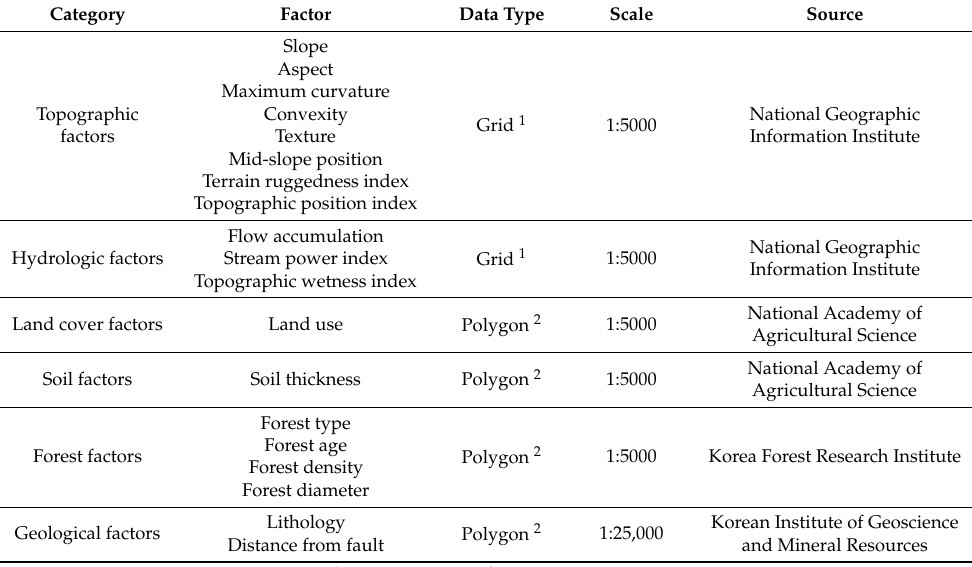
Table 1. Data layers related to landslide susceptibility in the study area.